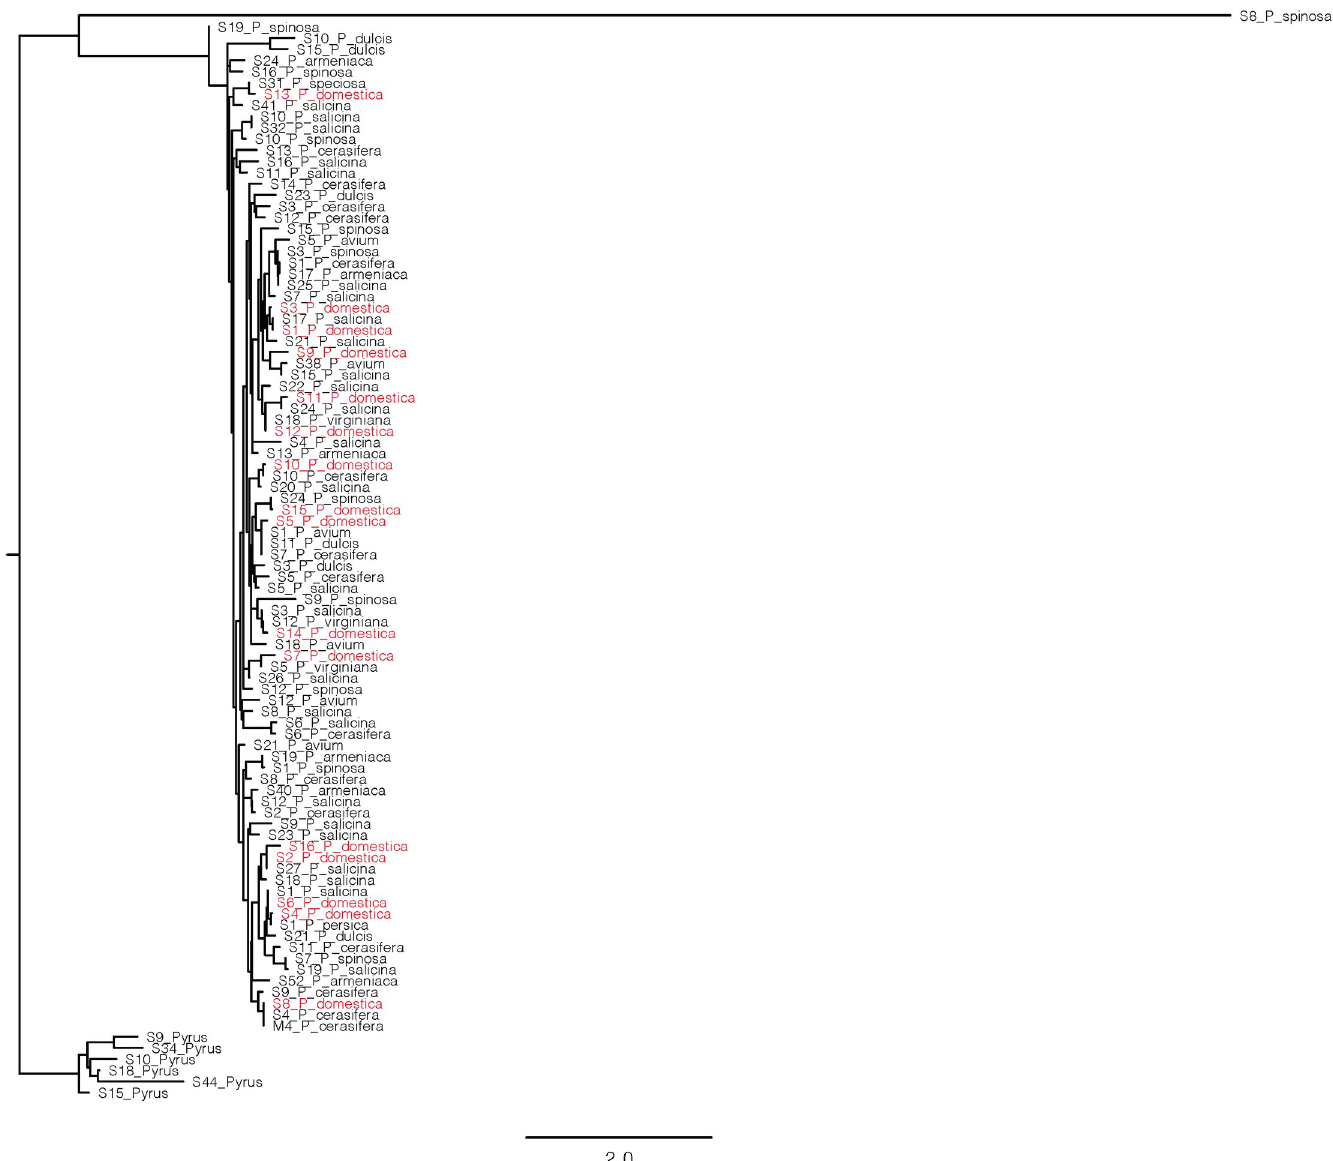
Fig 4. Phylogenetic relationships among S -RNase alleles from Prunus species including, the 17 alleles identified in this study. Pyrus was used as an outgroup.